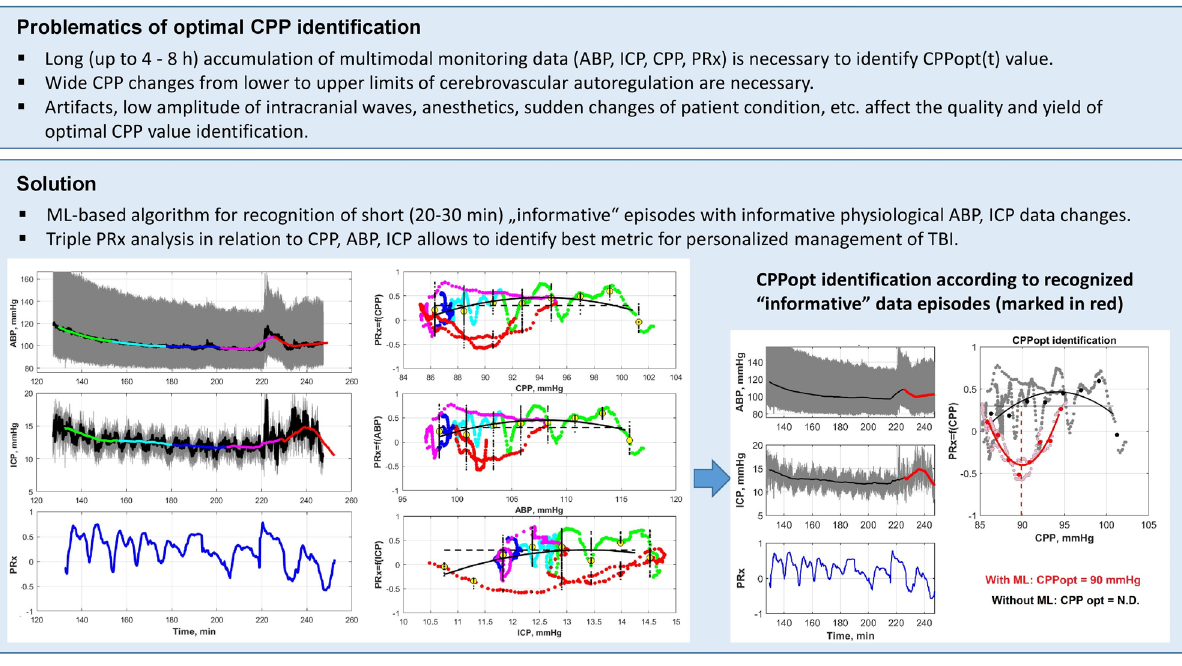
Each selected monitoring episode was divided into five color-marked segments that could be manually included or excluded into into PRx = f(CPP), PRx = f(ABP), PRx = f(ICP) graphs, thus allowing for the separate analysis of the influence of each of the color-marked segments on CPPopt value identification. The colors (green, cyan, blue, pink, and red) were assigned to each segment to separate and distinguish them along with the time window (Fig. 2).